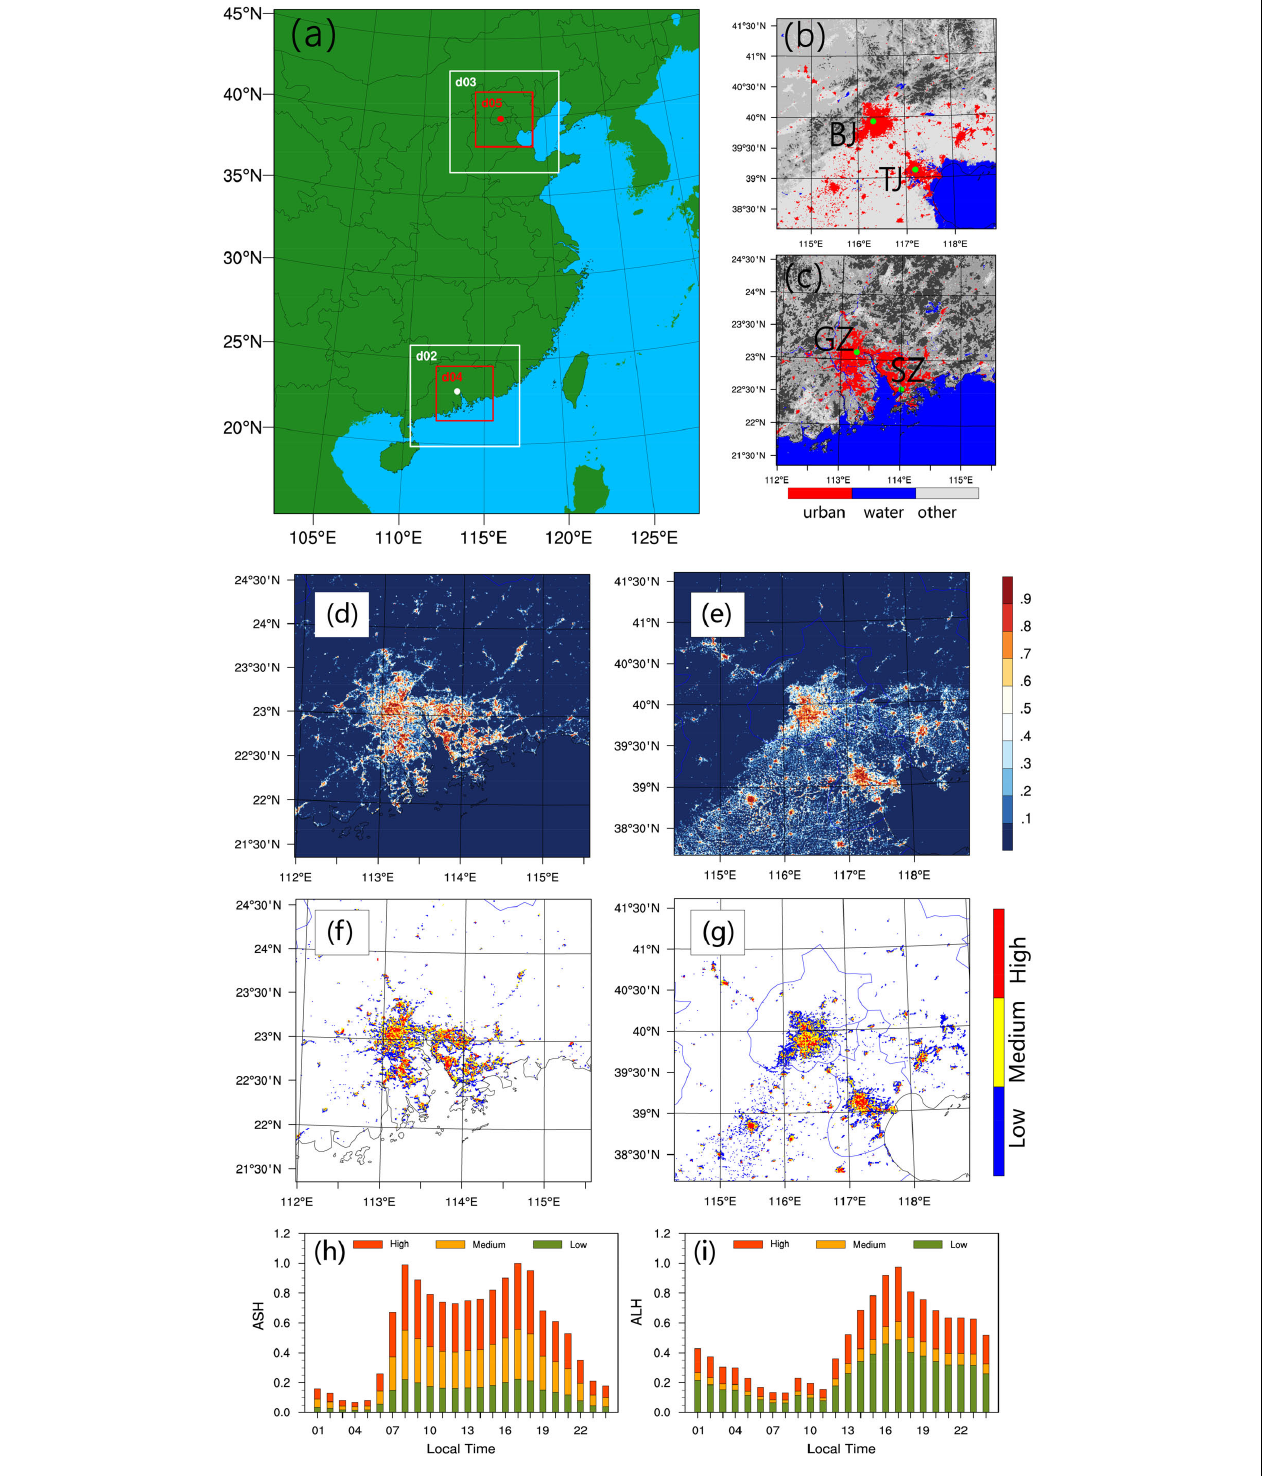
FIGURE 1 | (a) The nested simulation domains; (b) land cover for JJJ, and (c) PRD city cluster regions (red) in 2019, Beijing (BJ), Tianjin (TJ), Guangzhou (GZ), and Shenzhen (SZ) cities are marked; (d,e) the impervious surface ratio maps; (f,g) , the high-, medium-, and low-density cities retrieved from impervious surface ratio for PRD (left) and JJJ (right). In panels (b,c) , the black shaded regions show the terrain north of PRD and northwest of JJJ, while red, blue, and gray indicate urban, water body and other land uses. In panels (f-g) , red, yellow, and blue denote high-, medium-, and low-density cities. The diurnal cycle coefficients of panels (h) ASH and (i) ALH in high-, medium-, and low-density cities. By acting on AH values in Table 3 , these coefficients are used to produce gridded ASH and ALH (W m − 2 ) values in high-, medium-, and low-density cities, characterized by diurnal variation, to be added into the model.